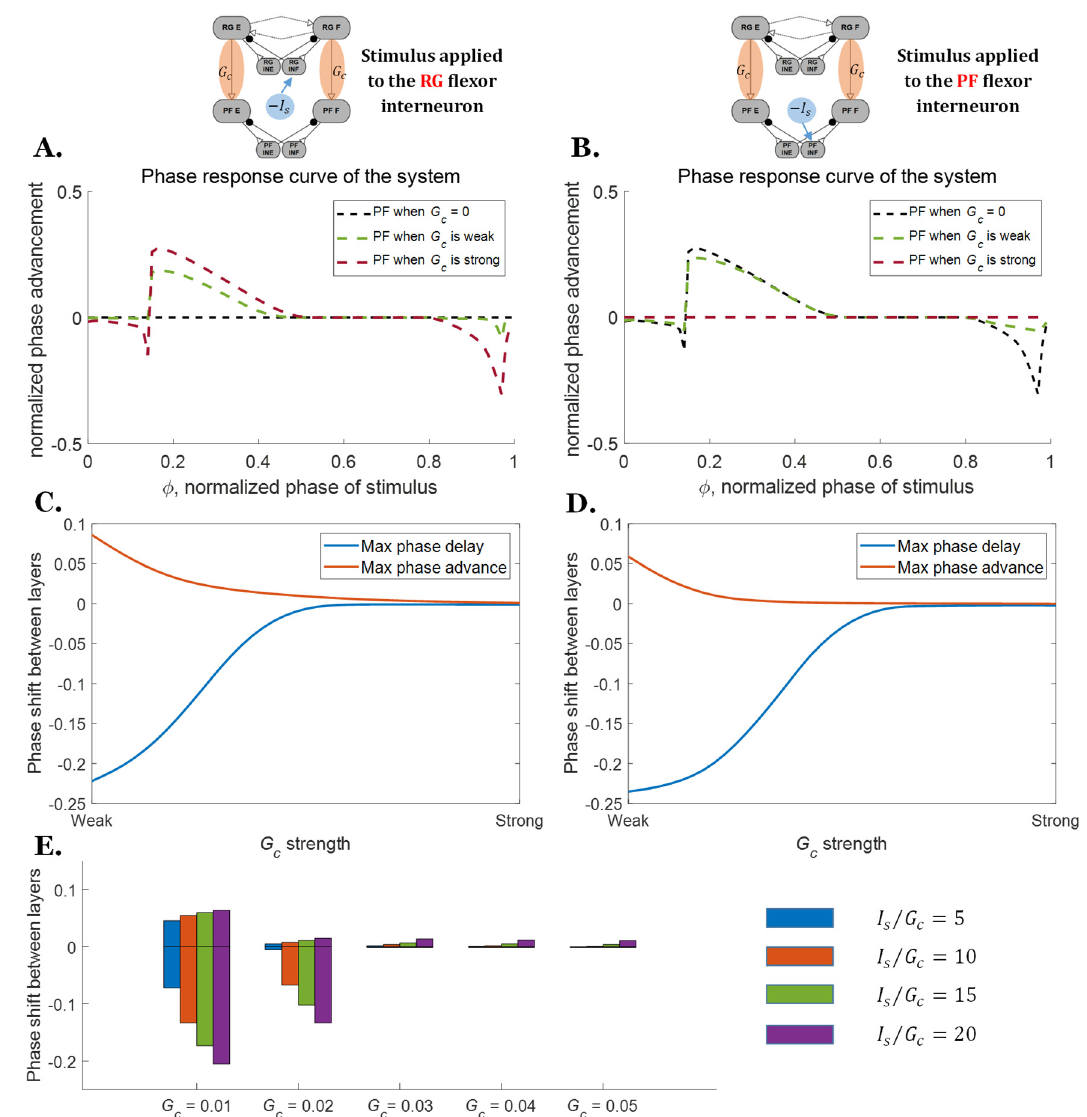
Figure 6. PRCs of the two-layer CPGs when perturbed with the stimulus of different magnitudes or at different phases. ( A ) PRCs of the two-layer CPG when the inhibitory stimulus is applied to the RG flexor interneuron. ( B ) PRCs of the two-layer CPG when the inhibitory stimulus is applied to the PF flexor interneuron. ( C ) Maximum possible phase shifts between the two layers when the stimulus is applied to the RG layer. ( D ) Maximum possible phase shifts between the two layers when the stimulus is applied to the PF layer. ( E ) Range of possible phase shifts between the two layers for different I s / G c ratios when the stimulus is applied to the RG